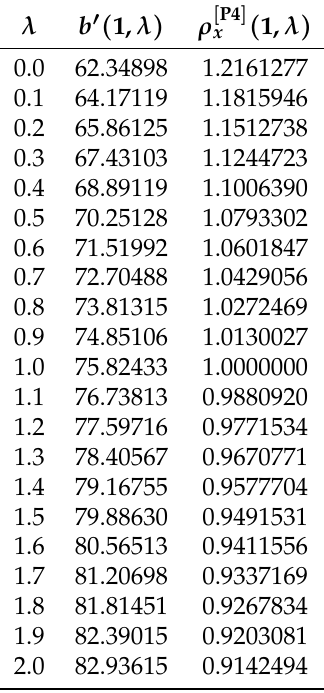
Table 16. Product P4 (enhanced pension); x = 65, b = 100, b (cid:48)(cid:48) =